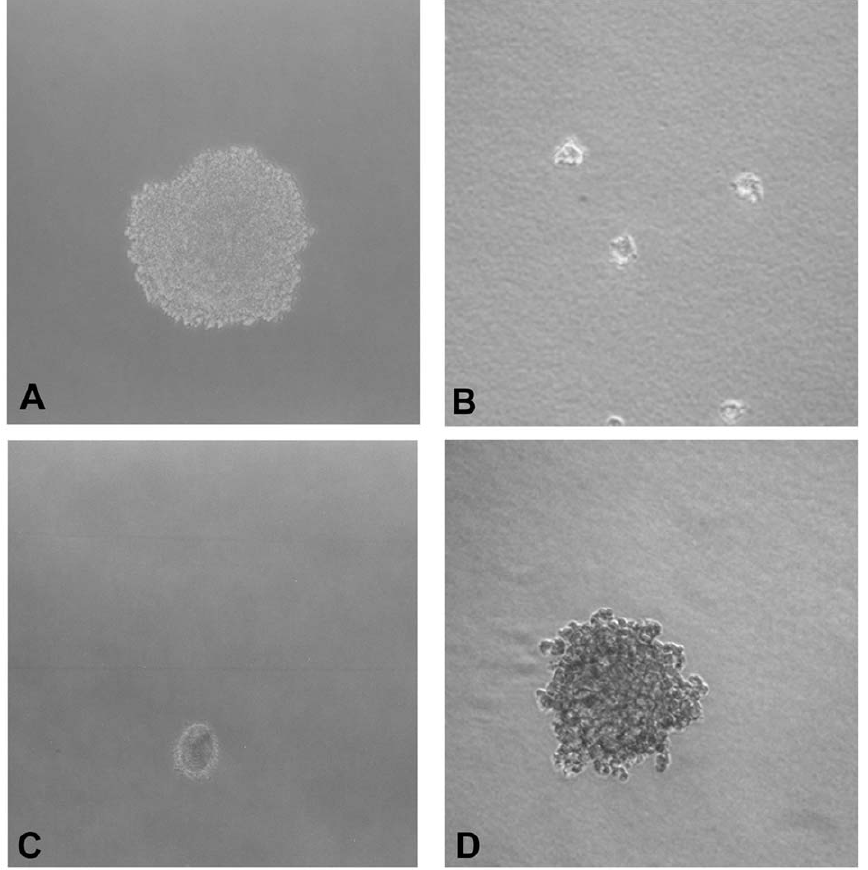
Figure 1. Anchorage Independent Growth Induced by Expression of CEACAM1-4S. ( A ) A representative anchorage independent colony formed by parental 253T cells after 3 weeks in soft agar. ( B ) Sparsely scattered single cells that typified soft agar cultures of 253T-NT cells. ( C ) Scattered cells remaining after 3 weeks in soft agar cultures of 253T-NT cells stably transfected with empty vector. ( D ) A representative colony formed by253T-NT cells stably transfected with a wild type CEACAM1-4S expression